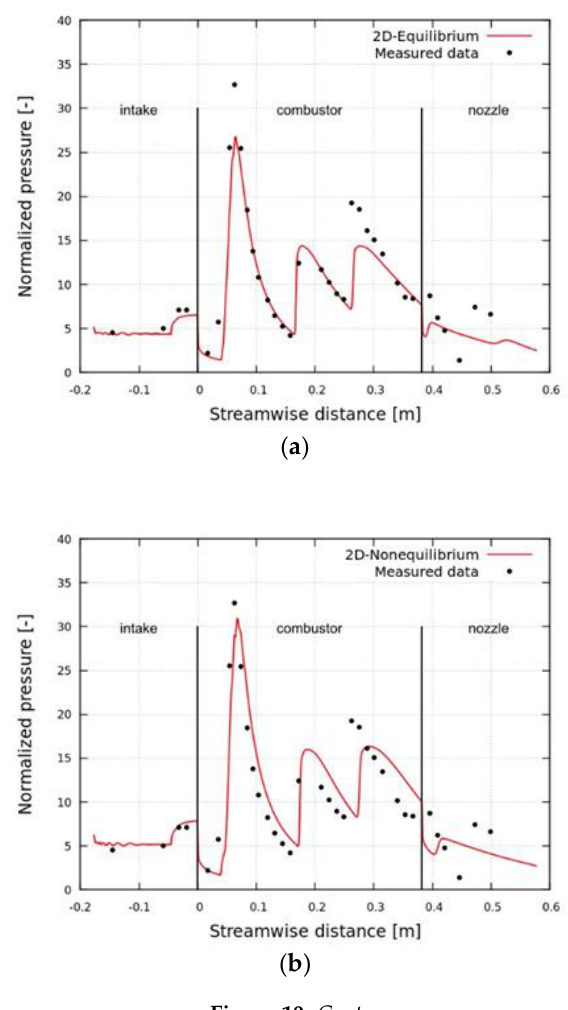
Figure 9. Pressure contours of ( a ) 3D-nonequilibrium case; ( b ) 3D-nonequilibrium case, zoomed in for the first shock reflection points for the x - y plane along z =